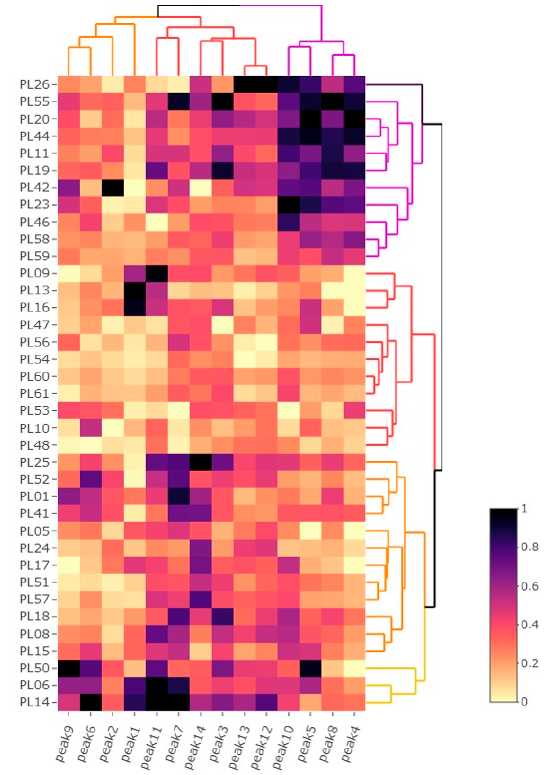
Figure 1. Hierarchical clustering analysis ( HCA) with a heatmap for the sprouts of the wheat